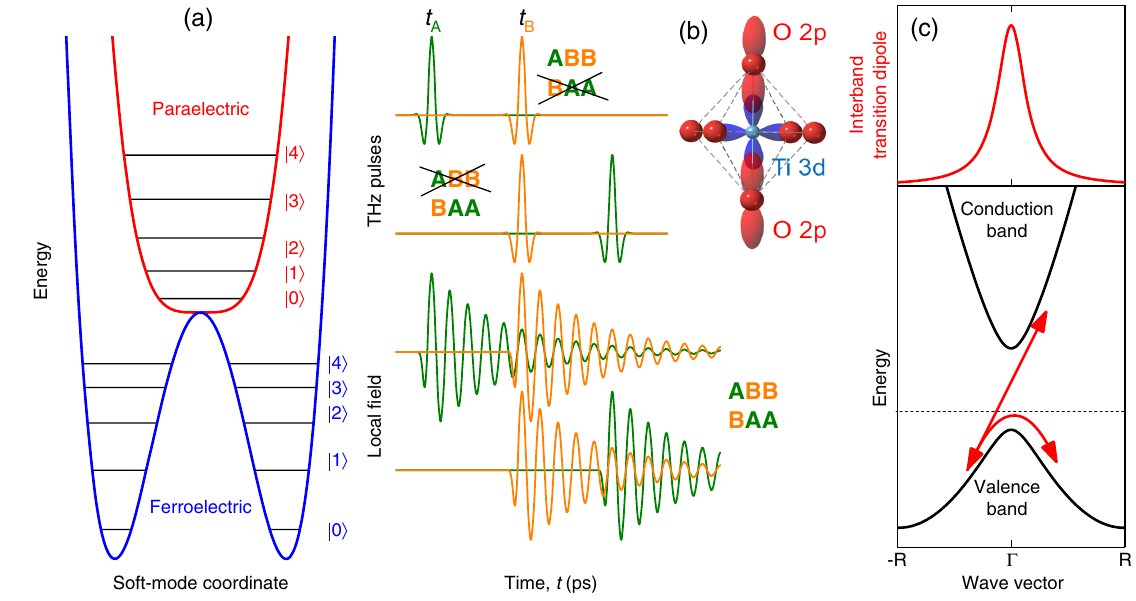
FIG. 1. (a) Sketch of the anharmonic soft-mode potential of a paraelectric (red) or ferroelectric (blue) perovskite. In its paraelectric phase, the ladder of vibrational energy eigenstates shows an increasing energy spacing for excited states. In contrast, in its ferroelectric phase, the spacing decreases. (b) Impact of local-field effects on the hybrid character of a soft mode. Both electronic interband dipoles, which are located on the Ti – O bonds (here, SrTiO 3 ), and nuclear-displacement dipoles are strongly localized in real space at spatially disjunct positions. The local field experienced by individual dipoles is dominated by the electric field of all other dipoles [14], which leads (in contrast to the green and orange THz pulses) to protracted driving fields on all localized dipoles, thereby allowing rephasing photon-echo signals even for a reversed pulse sequence. (c) Dominating electronic nonlinear response at THz frequencies: Large excursions of a valence-band electron in k space, exploring regions of very different interband-transition dipoles (red